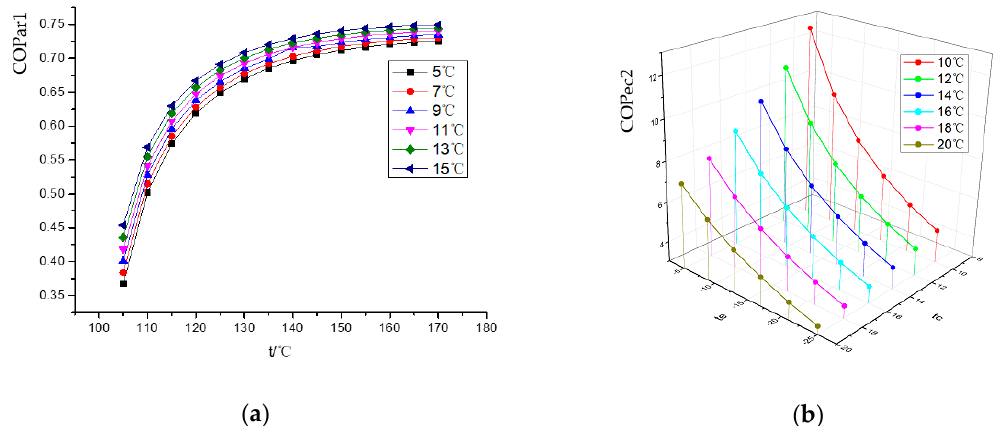
Figure 2. ( a ) E ff ect of heat source temperature on coe ffi cient of performance (COP) of absorption Figure 2. ( a ) Effect of heat source temperature on coefficient of performance (COP) of absorption refrigeration cycle (ARC); ( b ) E ff ect of evaporation temperature and condensation temperature on COP refrigeration cycle (ARC); ( b ) Effect of evaporation temperature and condensation temperature on of electrical compression refrigeration (ECR). COP of electrical compression refrigeration (ECR).